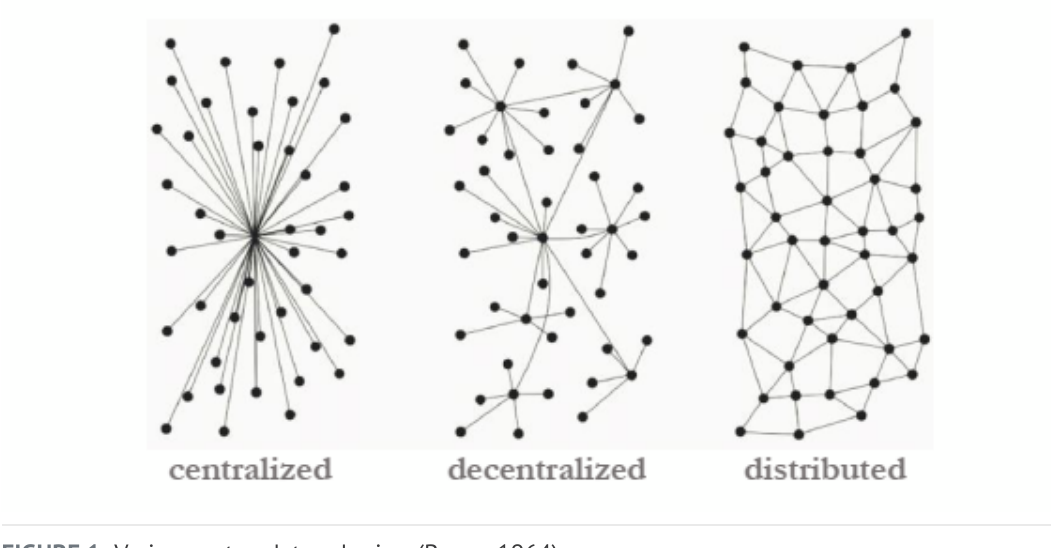
FIGURE 1: Various network topologies. (Baran,